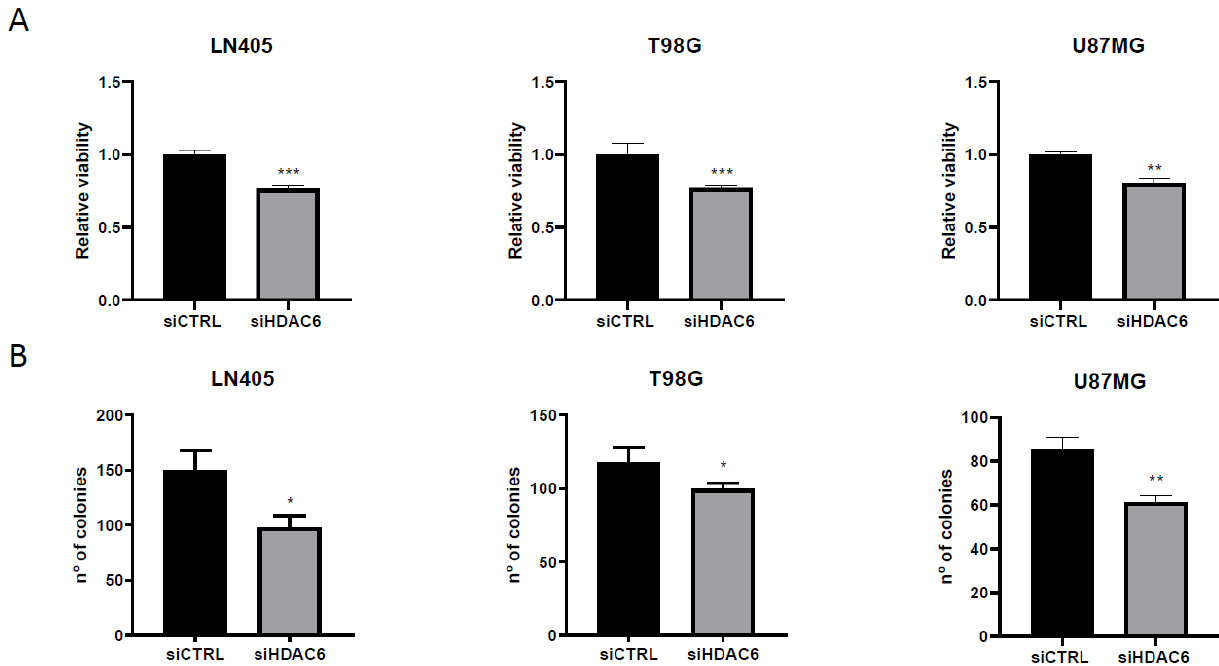
Figure 7. HDAC6 silencing reduces viability and clonogenic capacity in GBM cell lines. ( A ) Analysis of viability after 72 h of siRNAs treatment. (**) p < 0.01, (***) p < 0.001 vs. siCTRL condition ( n = 4 of three independent experiments). ( B ) Analysis of number of colonies counted after siRNAs treatment. Data are represented as mean ± SD (*) p < 0.05, (**) p < 0.01 vs. siCTRL condition ( n = 3 of three independent experiments).